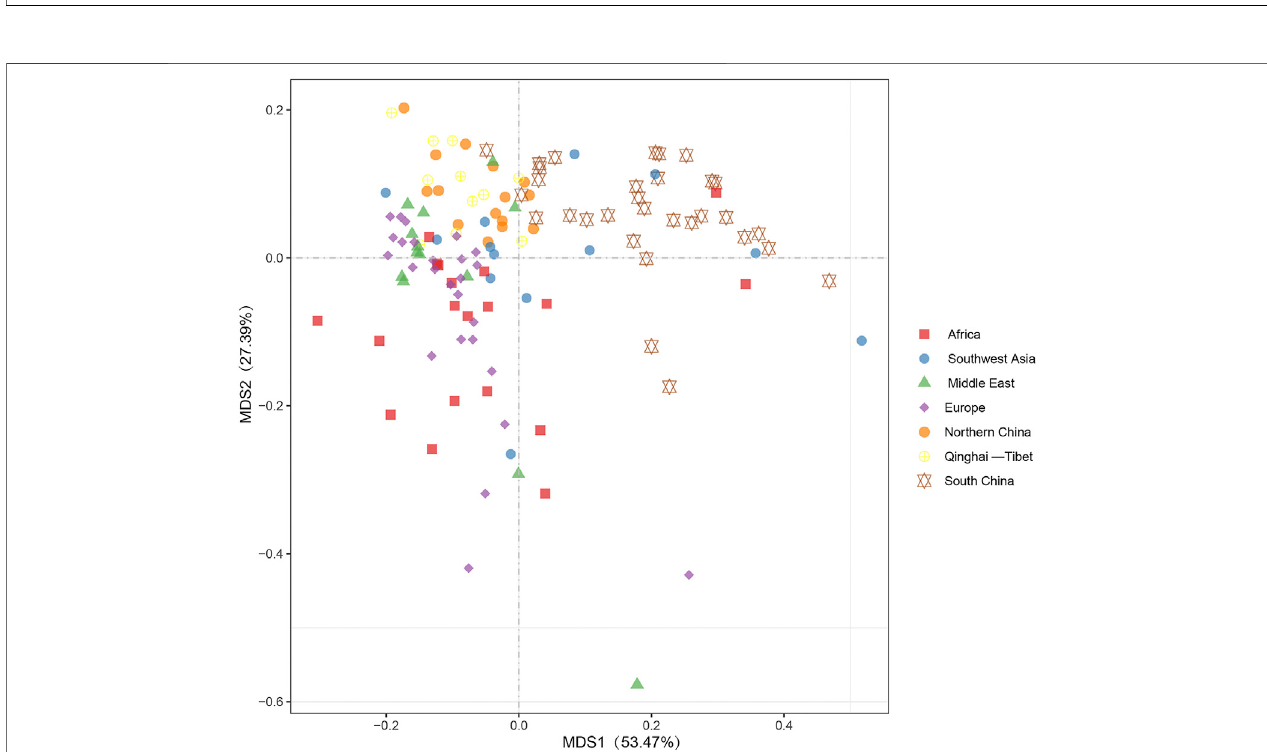
FIGURE 4 | Multidimensional scaling (MDS) plot based on pairwise F ST values for goat populations from seven geographic areas.